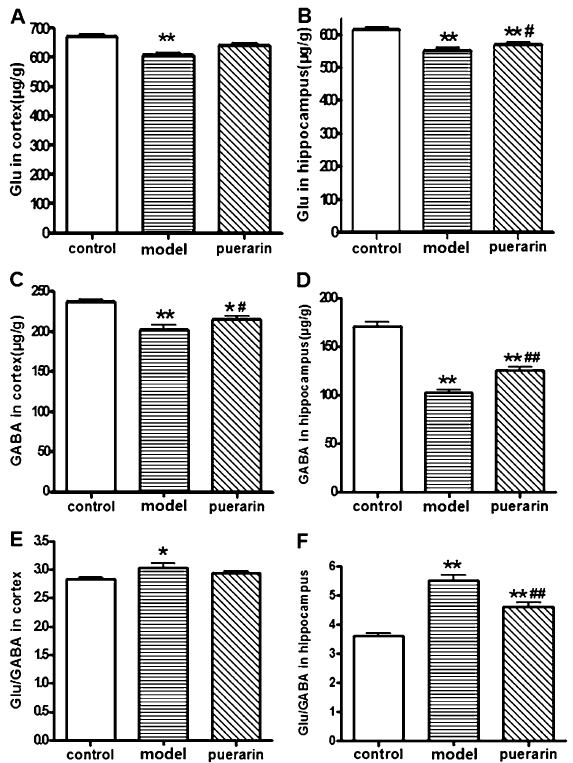
Figure 5. Detection of glutamic acid (Glu) and gamma amino butyric acid (GABA) by high-performance liquid chromatography (HPLC). A , B , Glu content of the cortex and hippocampus. C , D , GABA content of the cortex and hippocampus. E , F , Glu/GABA ratio in the cortex and hippocampus. *P , 0.05, **P , 0.01 vs control group; # P , 0.05, ## P , 0.01 vs model group (one-way ANOVA).